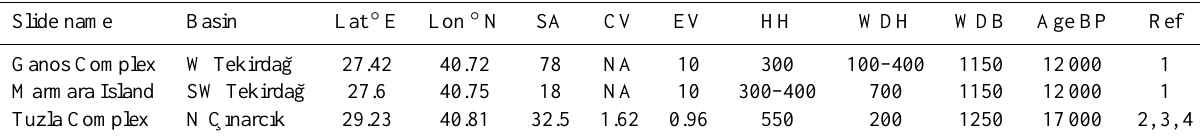
Table 2. Some of the most detailed submarine failures (highly probably co-seismic and